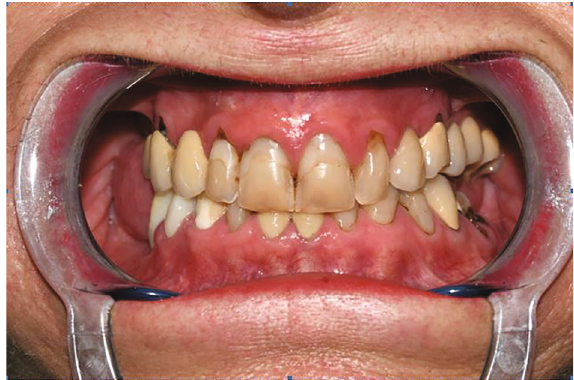
Figure 1: Preoperative intraoral status.